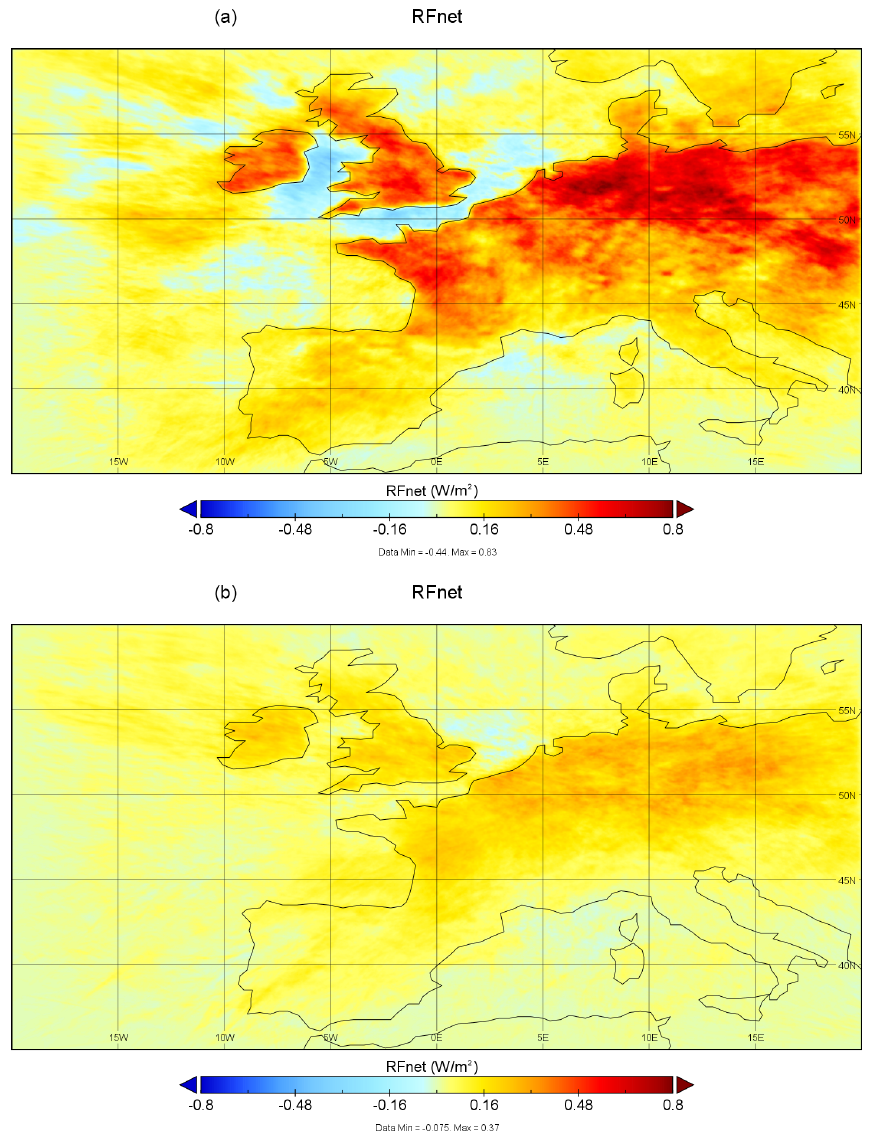
Figure 9. Mean net RF in Wm − 2 from contrails from March–August in 2019 (a) and 2020 (b)